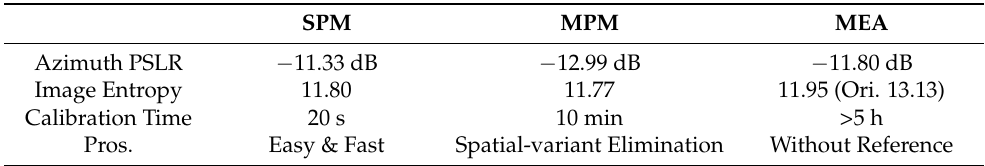
Table 4. Comparison of different calibration